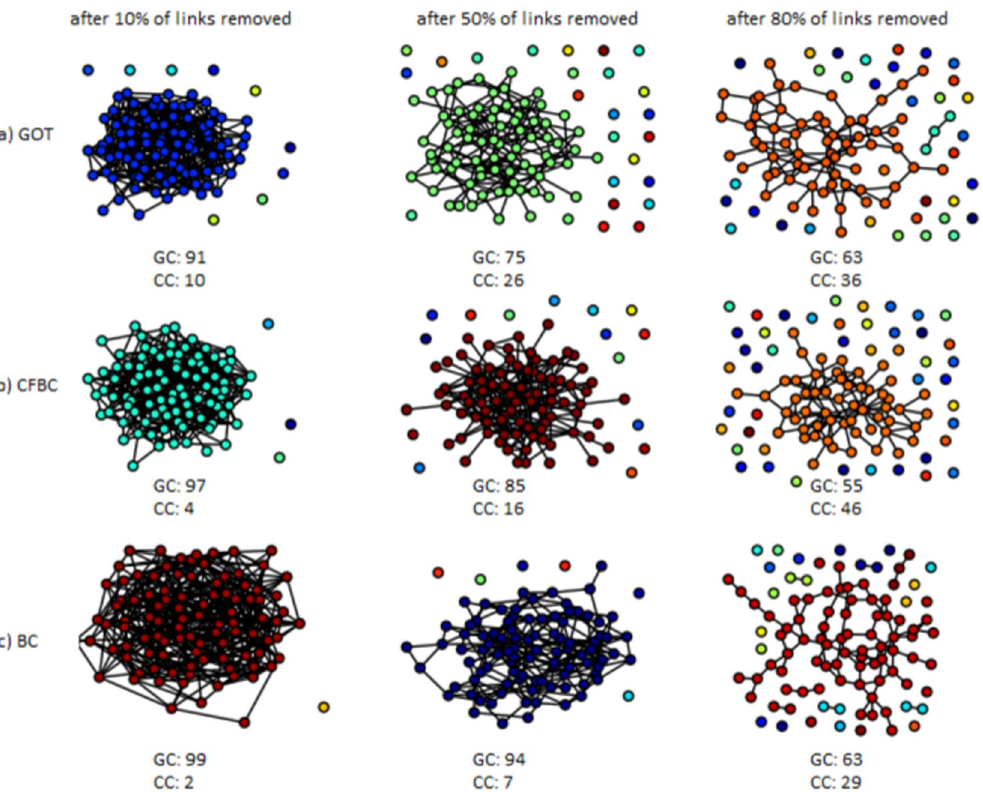
Figure 8. NRP procedure - links. Snapshots during the NRP procedure for links in a random generated network with 100 nodes. At the bottom of each subplot, the number of connected components (CC) and the size of the giant component (GC) are